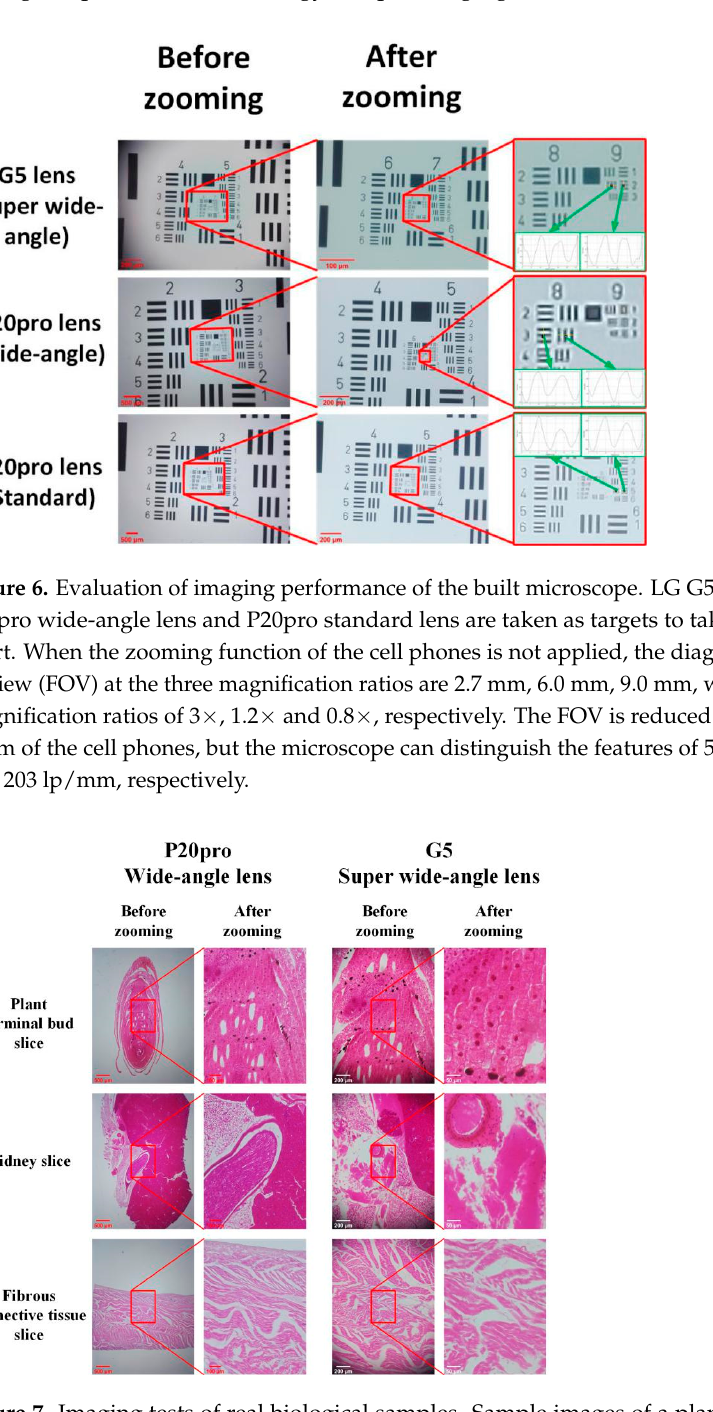
Figure 7. Imaging tests of real biological samples. Sample images of a plant terminal bud slice, a kidney slice and a fibrous connective tissue slice are obtained with the built microscope using the P20pro wide ‐ angle lens and the LG G5 Super wide ‐ angle lens as objectives. We also used the zoom function in the imaging